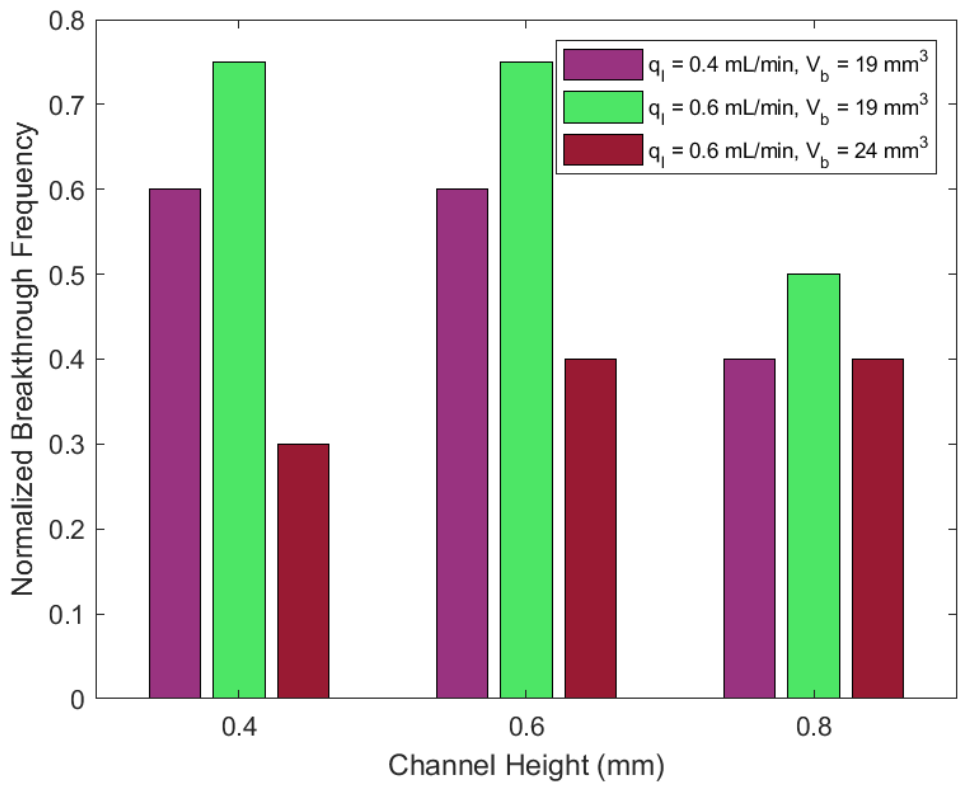
Figure 8. The normalized breakthrough frequencies (breakthrough frequency/generation frequency) for each experiment. V b is the bubble volume.